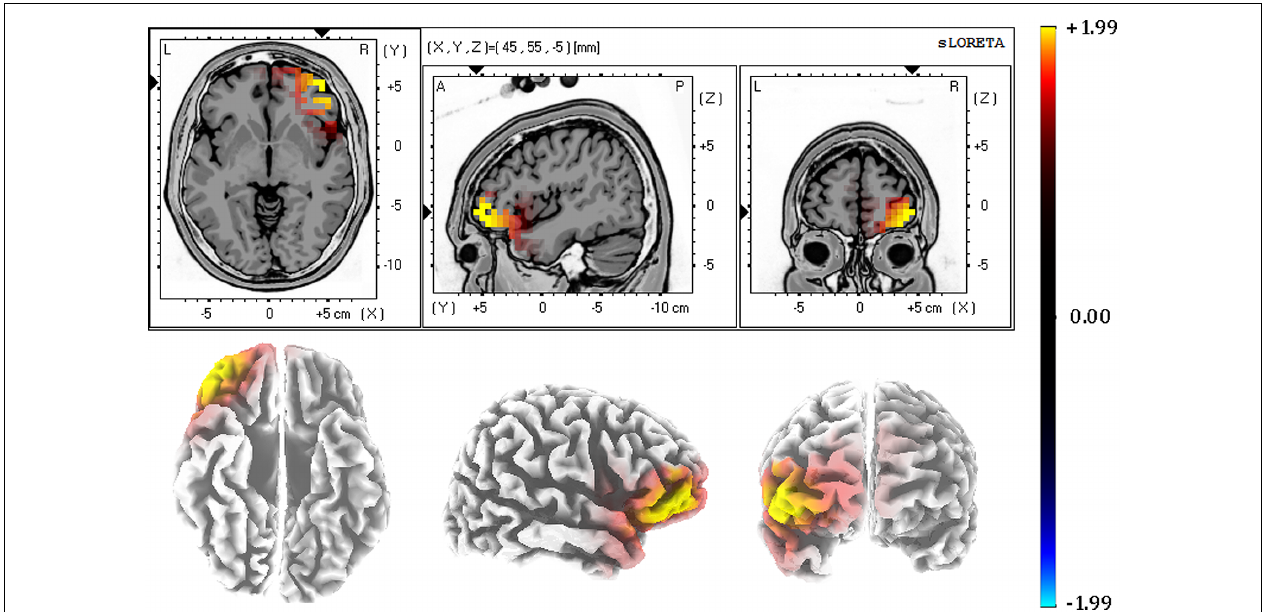
FIGURE 5 | Source localization results (eLORETA): increased N1-related activation to positive in comparison to neutral distractor words was observed in the orbitofrontal cortex. Color bar represents voxel log-F ratio